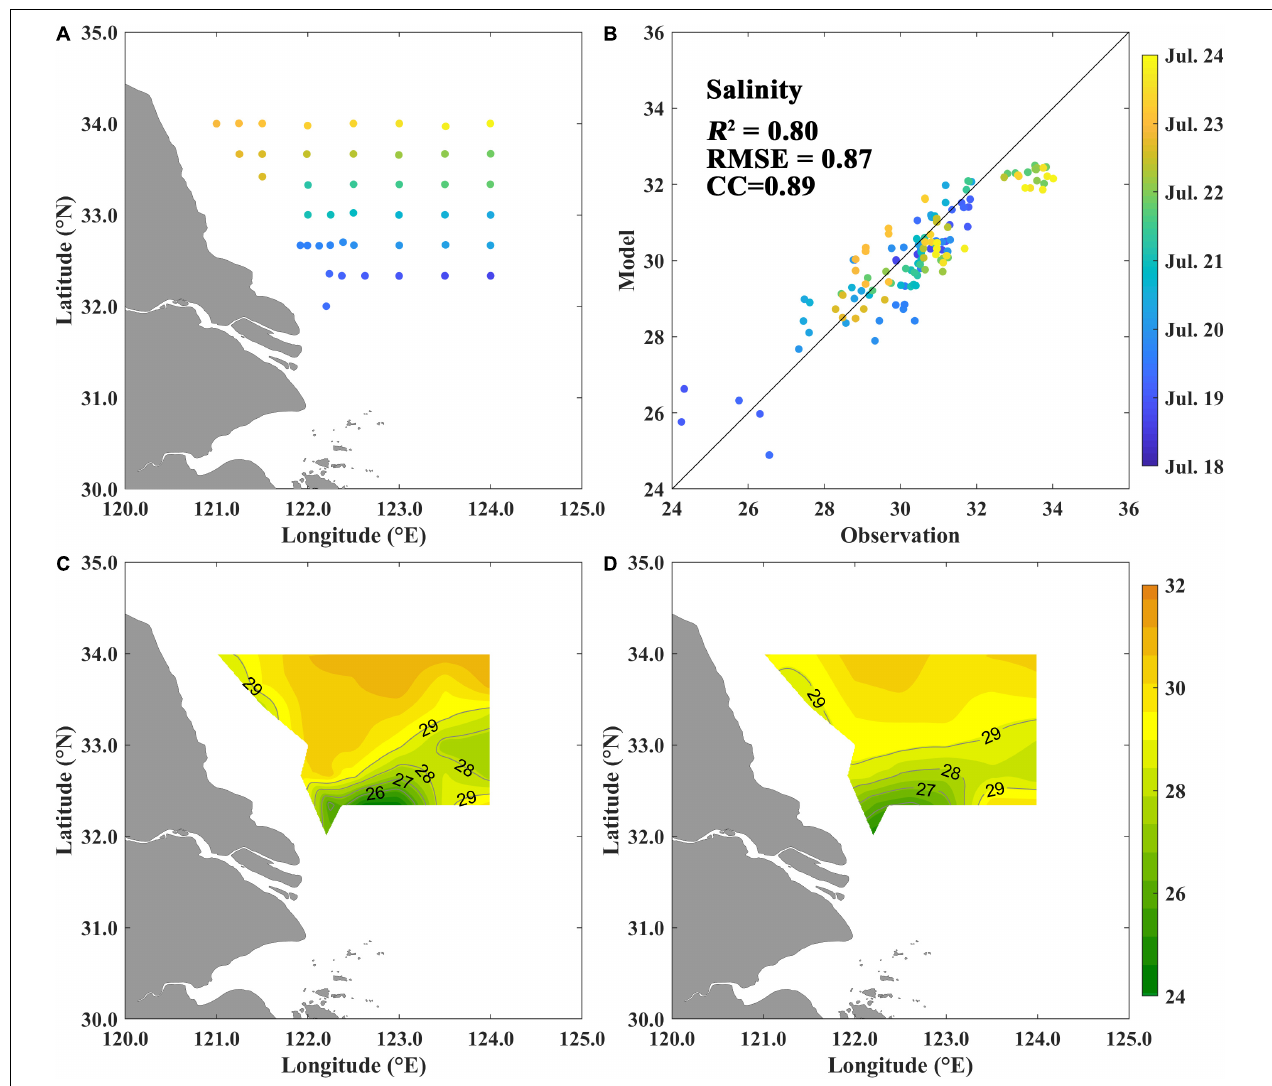
FIGURE 2 | (A) Distribution of the observation stations and (B) the comparison between the (C) observed and (D) modeled salinity during the second cruise from July 18 to 24, 2006. Color in panels (A,B) indicate the date of